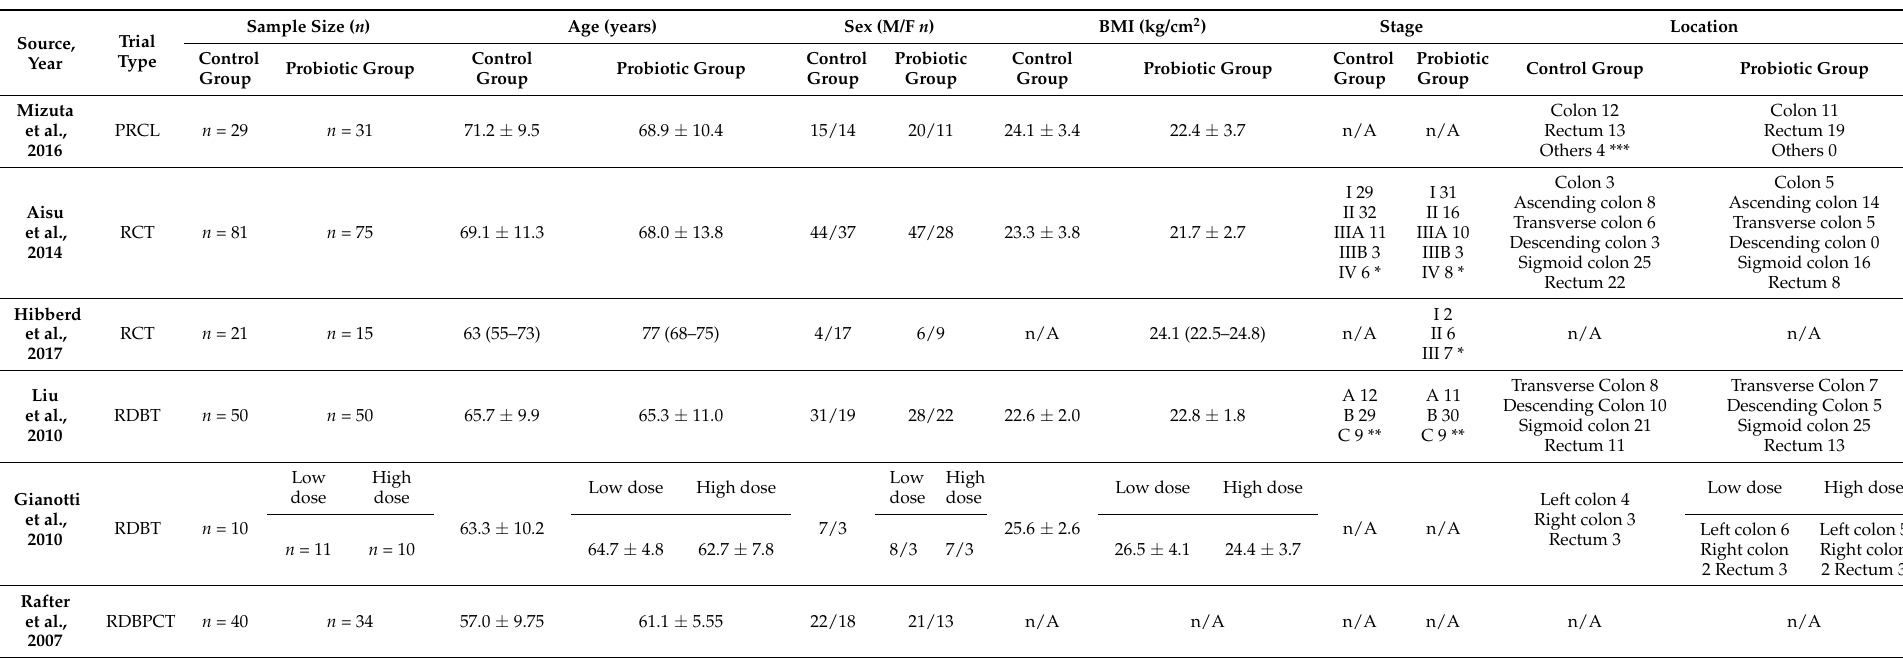
Table 1. Characteristics of enrolled population ( n =